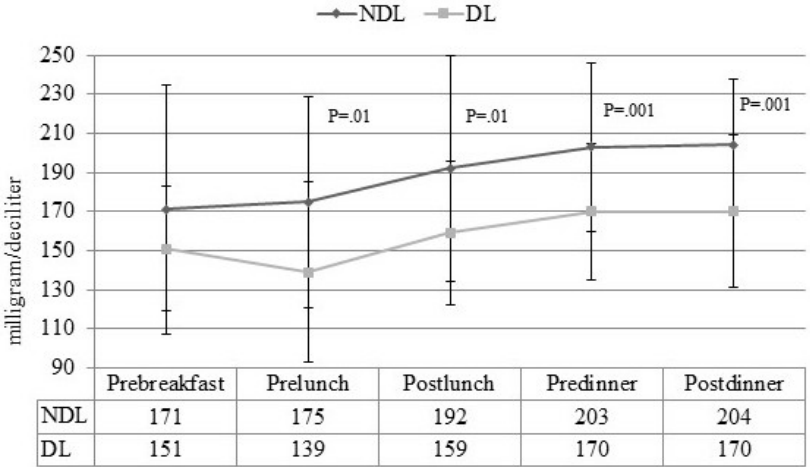
Figure 3. Self-monitoring blood glucose of No-downloader (NDL) and Downloader (DL) at follow-up visit.